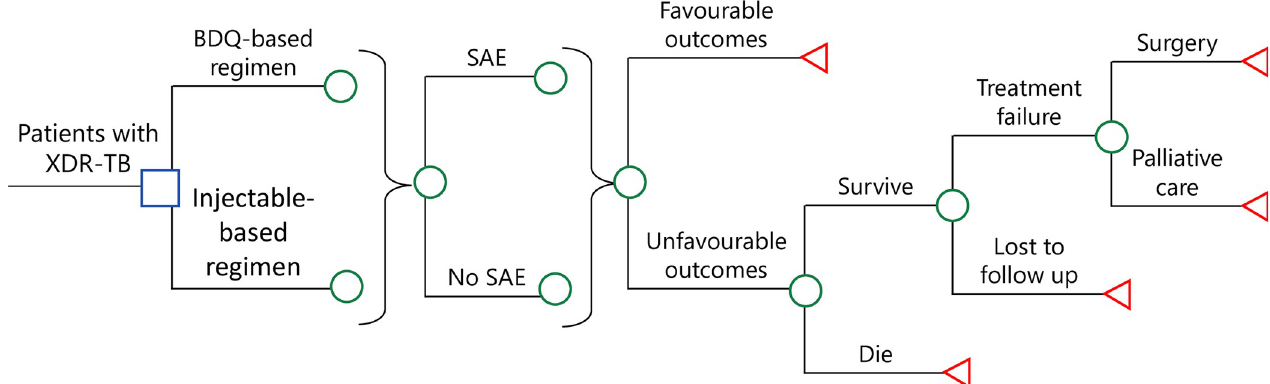
Fig 1. Simplified decision-analytical model for XDR-TB treatment with BDQ-based regimen versus injectable-based conventional regimen. BDQ: Bedaquiline; SAE: Serious adverse event; XDR-TB: Extensively drug-resistant tuberculosis.